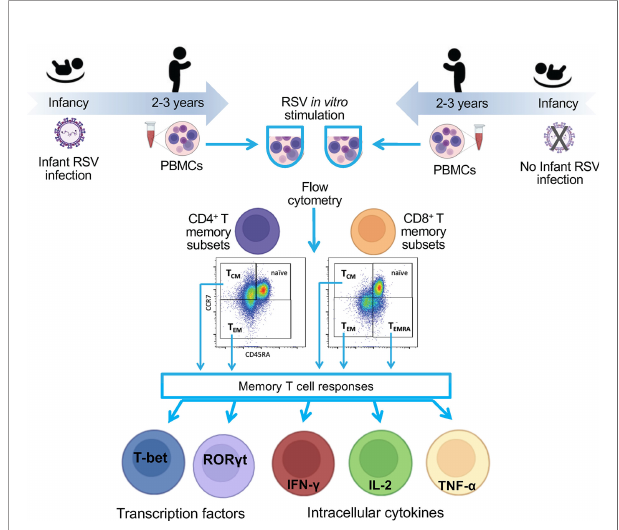
FIGURE 1 | Flow diagram of the study. To understand the impact of RSV infection in infancy on RSV memory T cell responses, we collected blood from a nested cohort of 75 children enrolled in the INSPIRE cohort who were or were not infected with RSV during infancy. The PBMCs were collected at ages 2-3 years. PBMCs were stimulated in vitro with RSV, and functional responses were measured within memory CD4 and CD8 T cell subsets by percentage of cell expressing nuclear transcription factor or intracellular cytokines. Results were compared between children infected with RSV during infancy and those who were